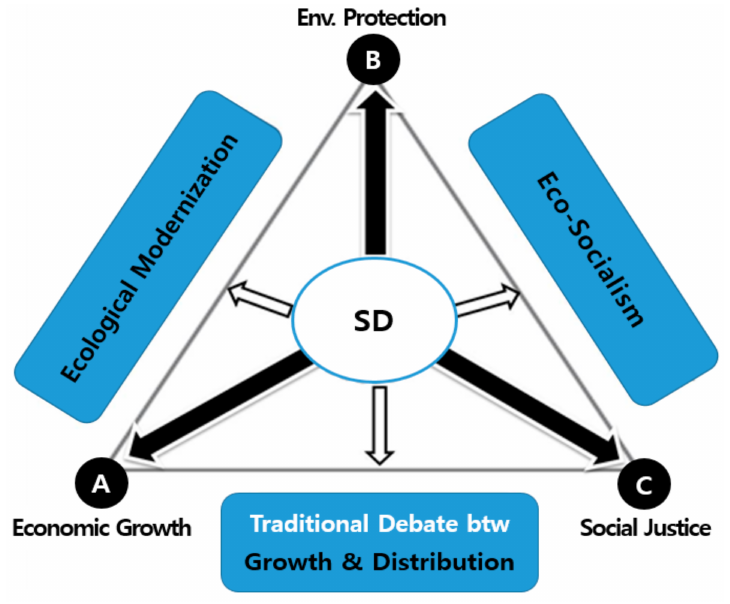
Figure 1. Three pillars of sustainable development and theoretical